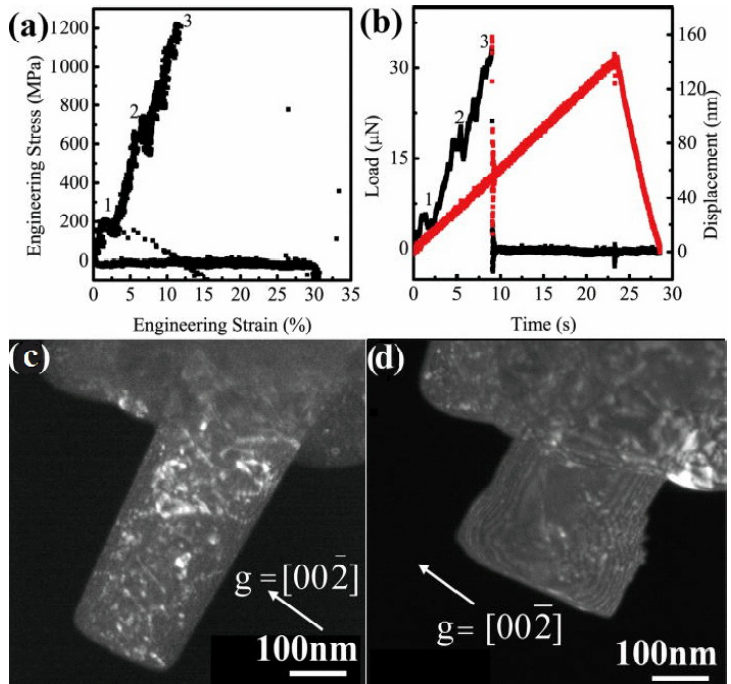
Fig. 15. Snapshots of the microstructural evolution in 165 nm Al nanopillar compression. (a) Engineering stress-strain curve (b) The load-time and displacement-time curves. (c) Dark-field images of the pillar before compression. (d) Dark-field images of the pillar after collapse (~20% strain). Reprinted with permission